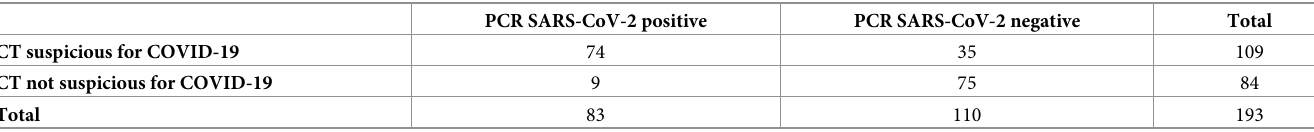
Table 2. Overview of chest CT and RT-PCR